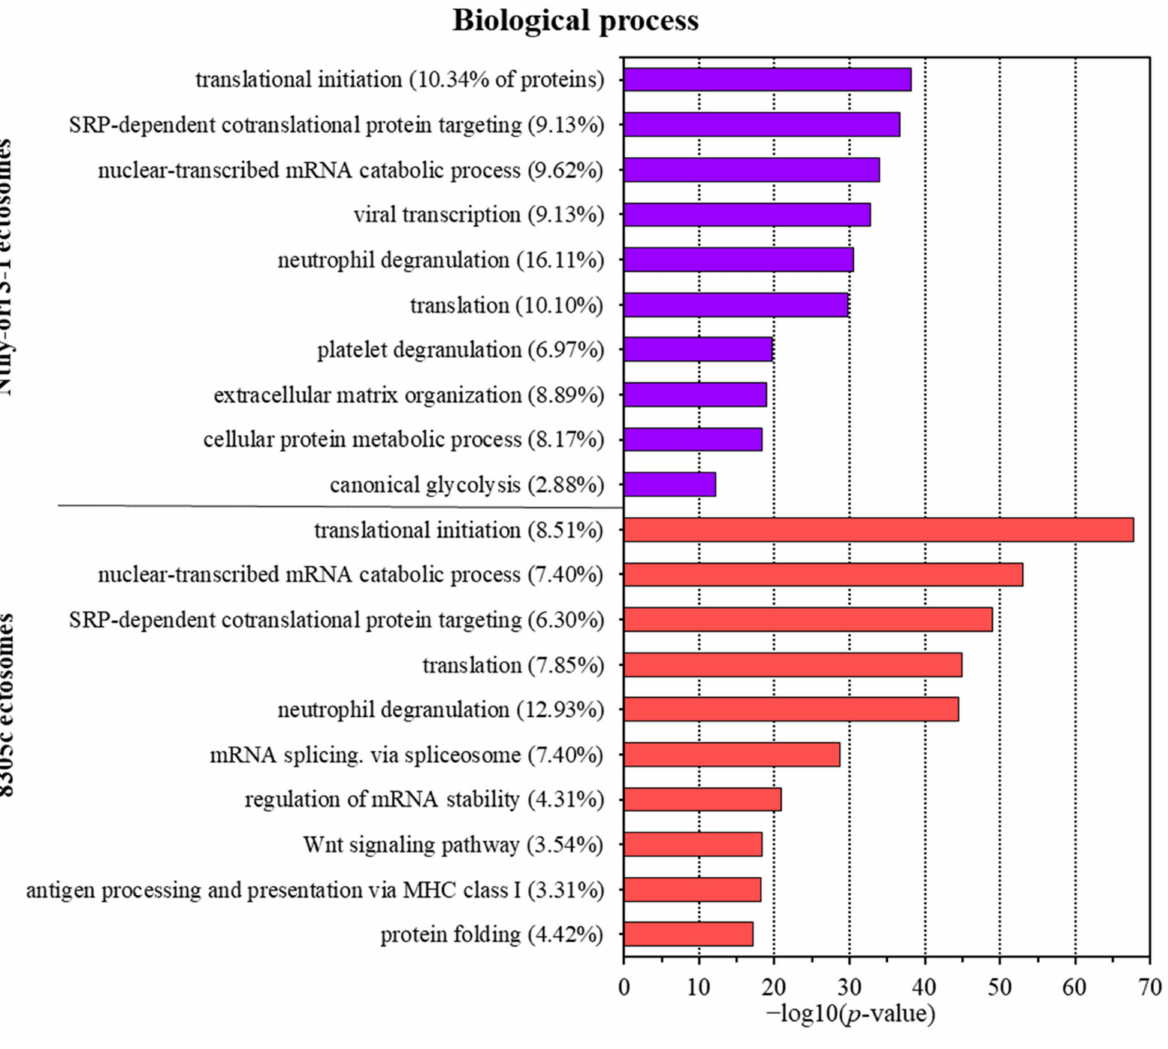
Figure 4. Gene ontology (GO) analysis of proteins identified in ectosomes derived from normal thyroid follicular epithelial Nthy-ori 3-1 cells and thyroid anaplastic carcinoma 8305C cells performed with the use of FunRich 2.0 software with UniProt database (release April 2021) as a reference. For GO term “biological process”, 10 categories with the highest statistical significance of protein enrichment within the specific category ( p < 0.001) are presented as graphs. Complete results of GO analysis are provided in Supplementary Data